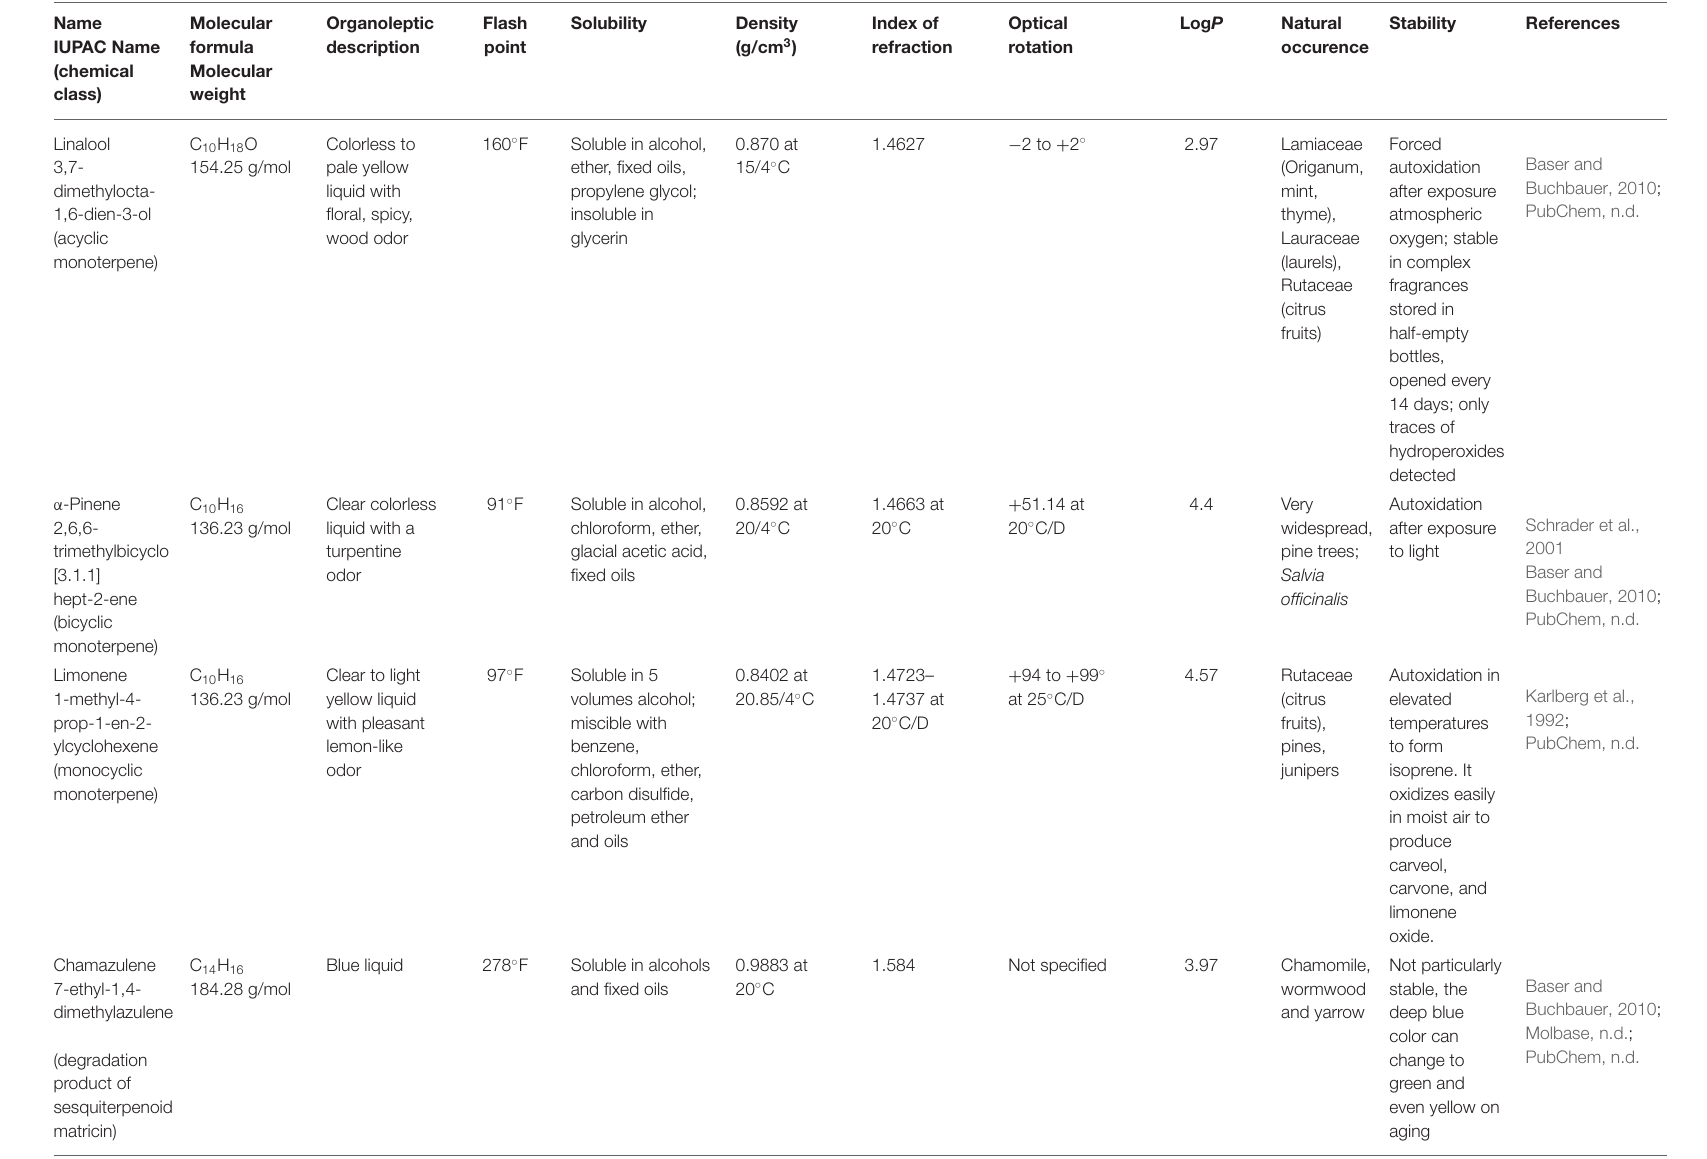
TABLE 1 | Physical characteristics of selected essential oils